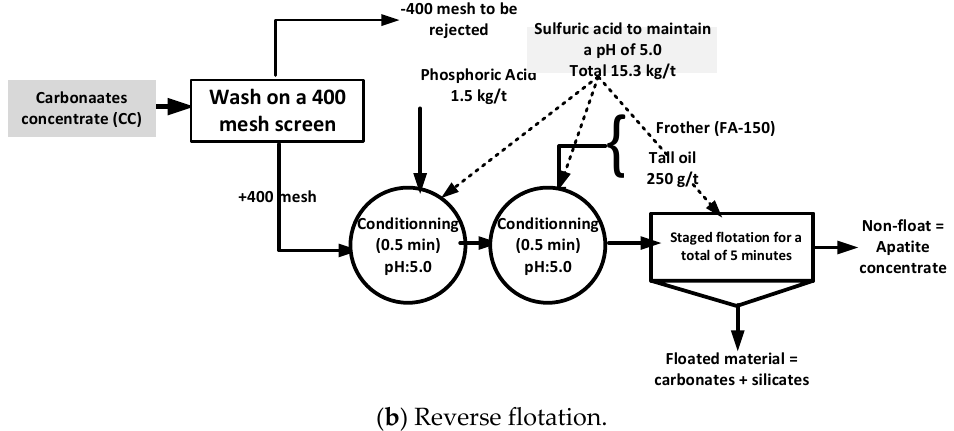
Figure 4. Test procedures used for direct and reverse flotation of apatite. ( a ) Direct flotation; ( b ) Reverse flotation. Table 6. Results of the direct flotation tests with one cleaning stage.